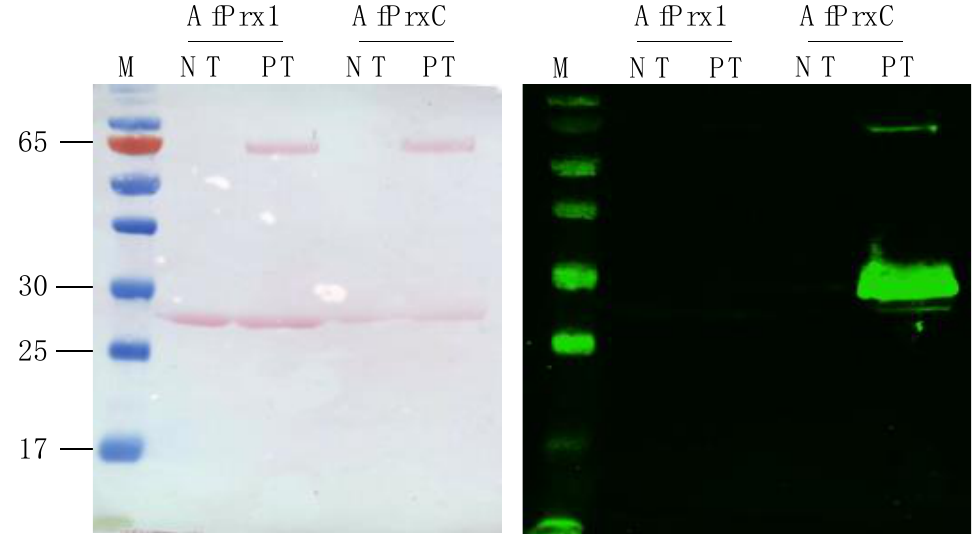
Figure 5. Evaluation of AfPrx1 and AfPrxC phosphorylation. Left panel represents the membrane stained with Ponceau S as the loading control. Right panel represents the Western Blot using the primary antibody for phosphorylated MmPrdx6. Lane 1: molecular ladder, the numbers at the left side represent the molecular weight (kDa); lane 2: non-treated (NT) AfPrx1; lane 3: AfPrx1 after phosphorylation treatment (PT); lane 4: non-treated AfPrxC; lane 5: AfPrxC after phosphorylation treatment. The lower bands represent the Prdx and upper bands represent the kinase Erk2. Phosphorylation treatment is described in the Material and Methods section.